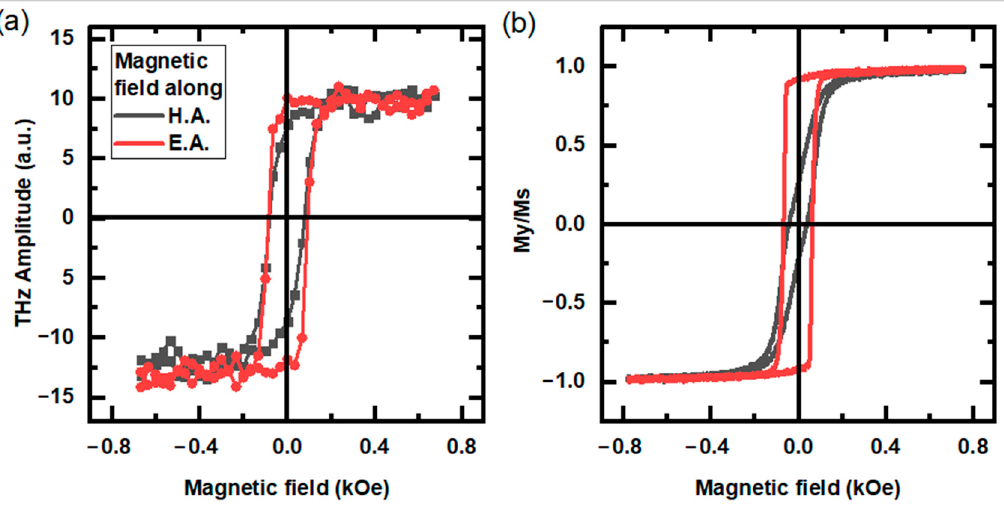
Figure 3. Magnetic hysteresis loops for a Co/WS 2 spintronic emitter for ( a ) a THz signal with an applied magnetic field in the EA and HA; ( b ) magnetization curve.